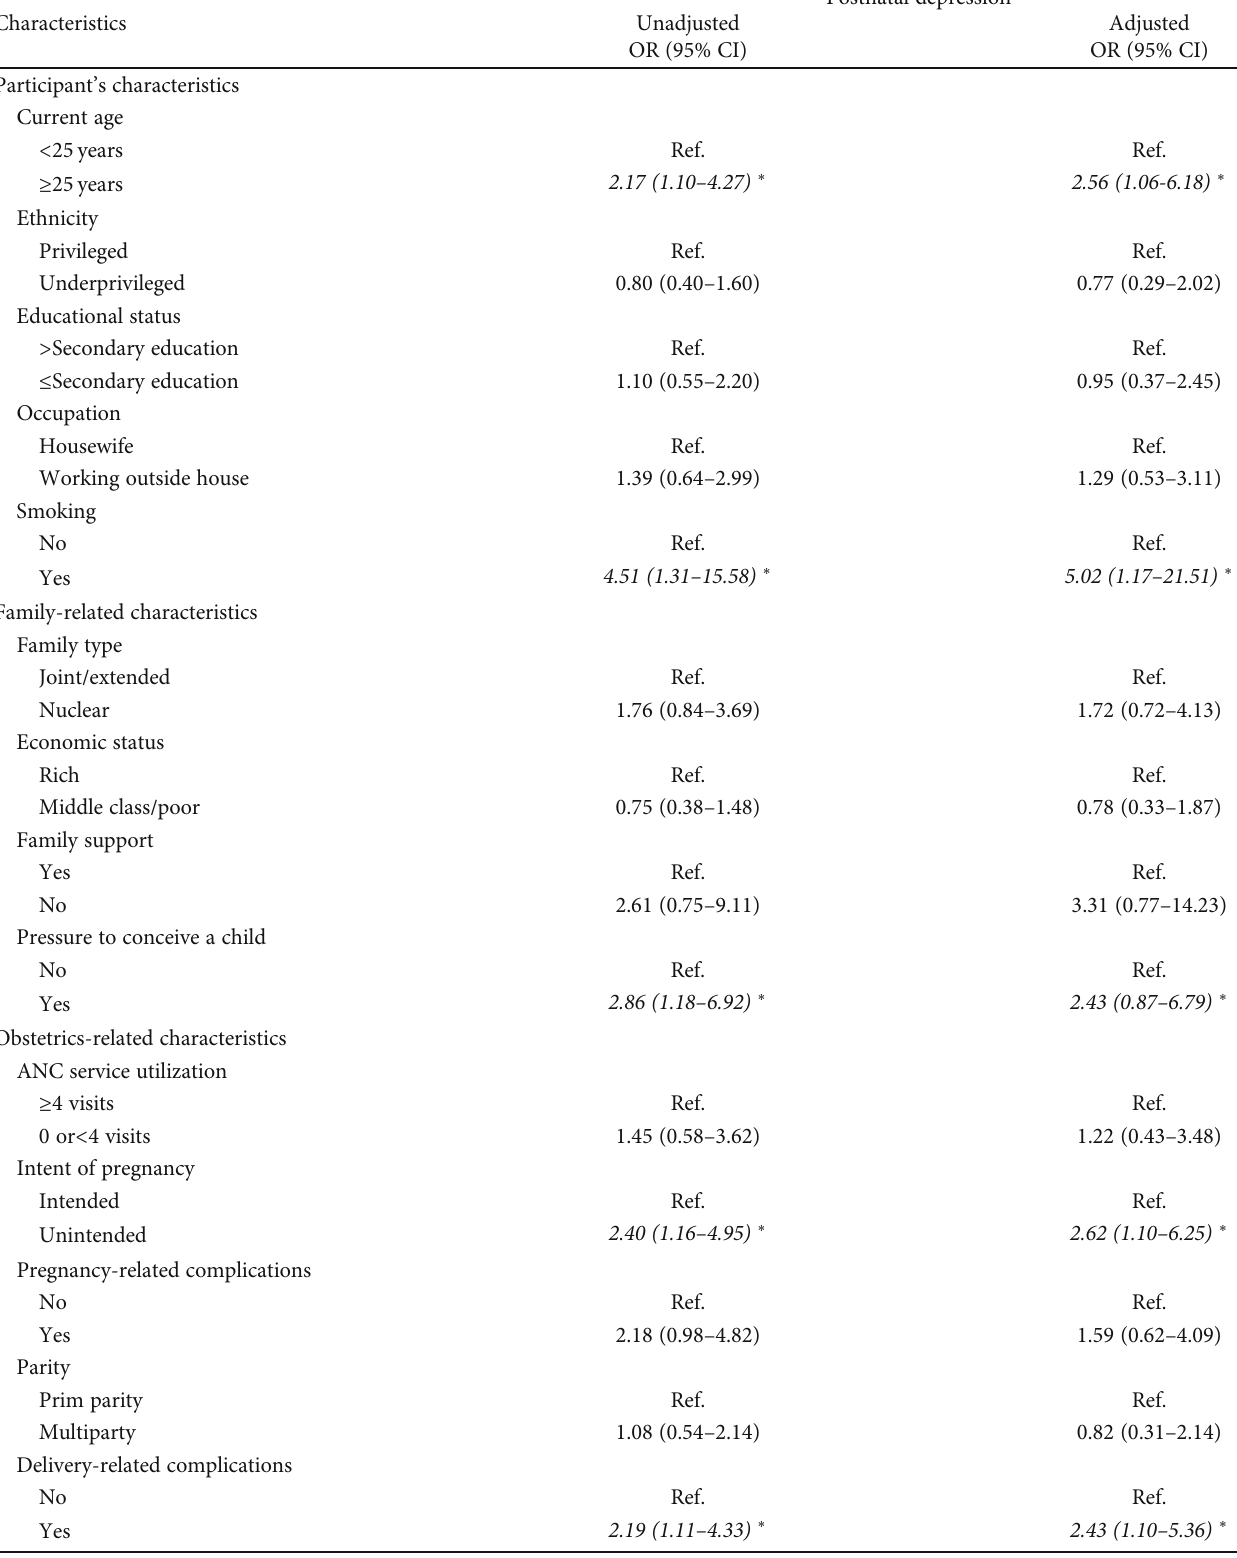
Table 2: Factors associated with postnatal depression ( n = 242